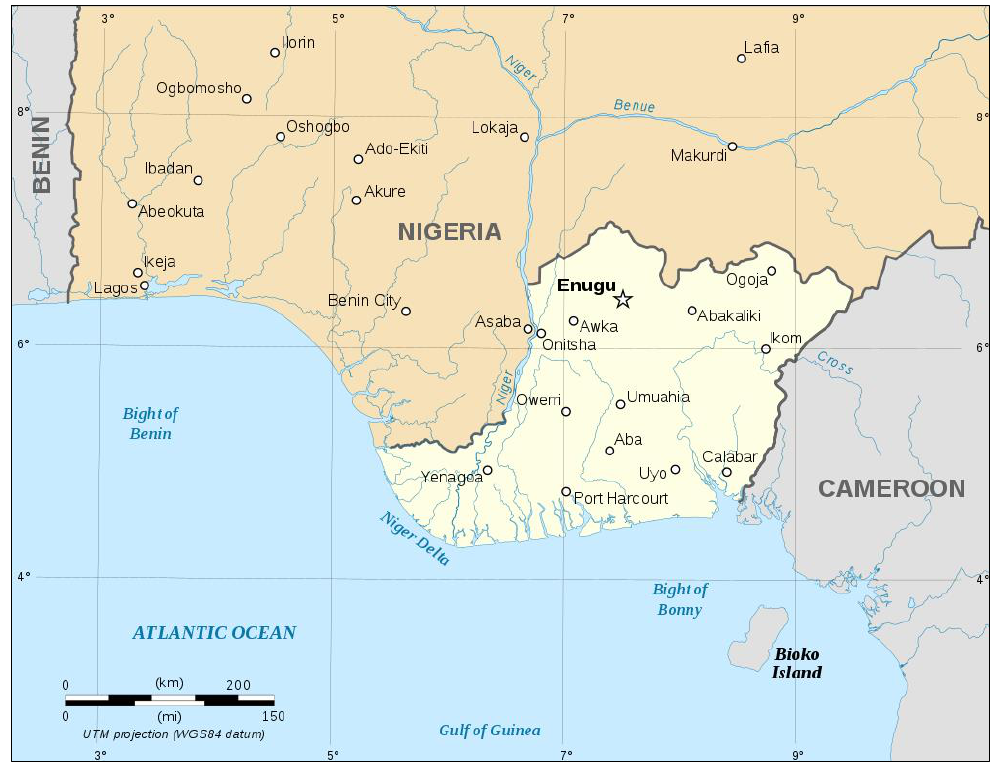
Figure 1. Map of Awgu in Enugu State showing location of study